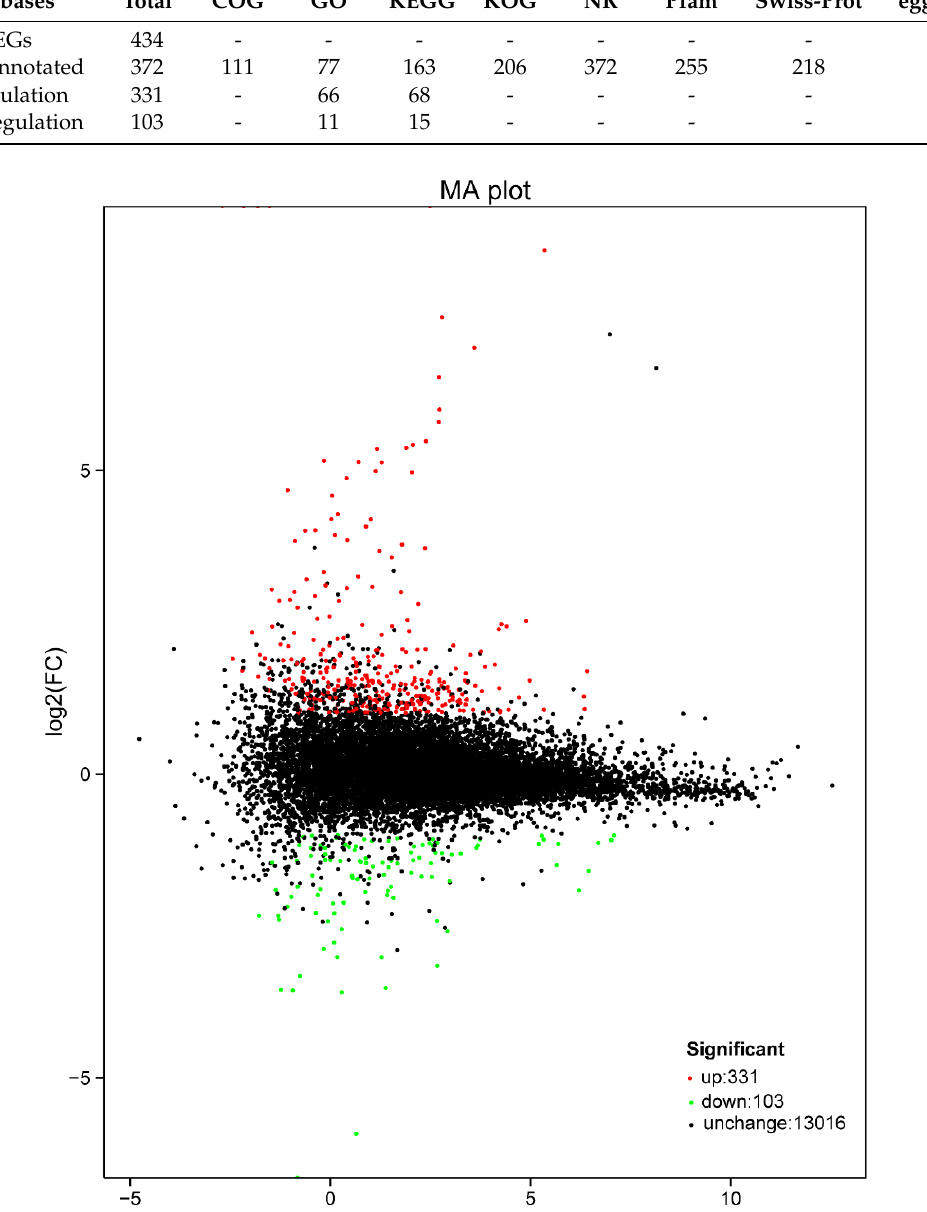
Figure 1. MA plot of the differences in gene expression of mated females relative to gene expression of virgin females.